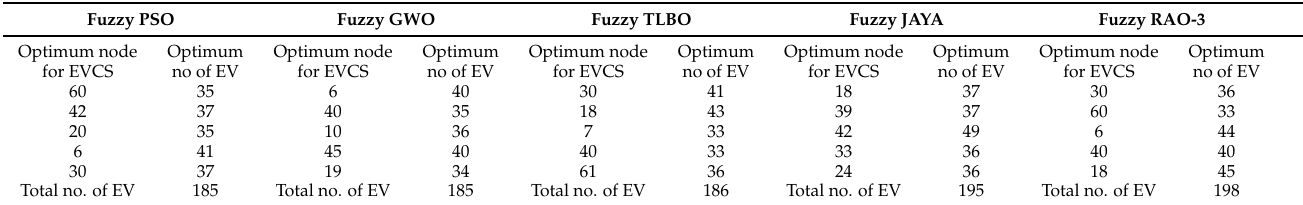
Table 5. Optimum number of EVs and optimum locations of EVCSs.